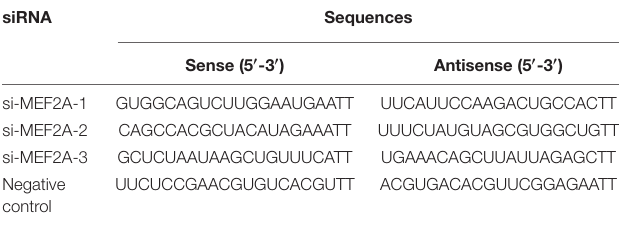
TABLE 2 | The siRNA sequences of MEF2A.